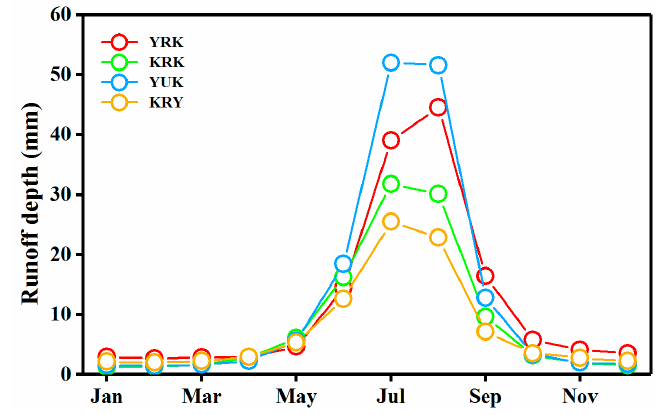
Figure 10. Variations in monthly mean runoff depth. Table 3. Frequency of occurrence of minimum and maximum monthly discharge in each month (unit: %).